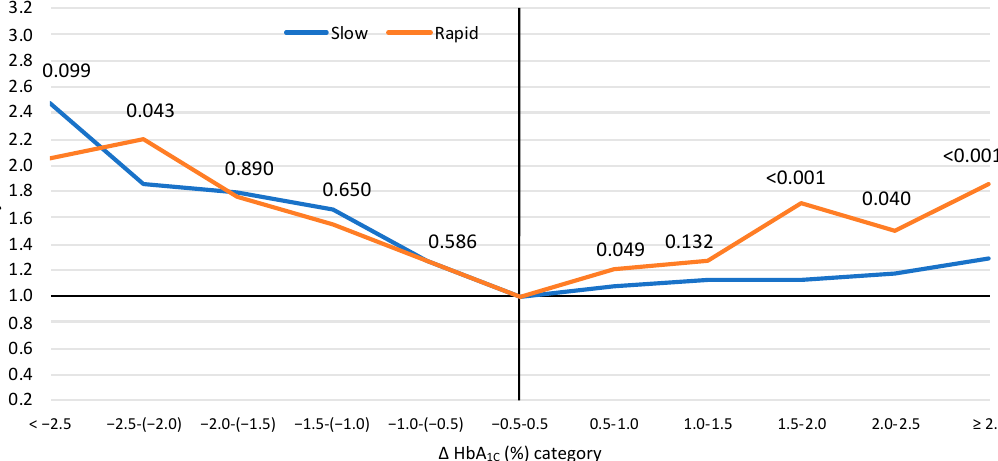
Figure 3. The relative risk (adjusted odds ratios) for mortality according to HbA 1C changes in the rapid- and slow-changing groups. Rapid change—time interval of ∆ HbA 1C values < one year; slow change—time interval of ∆ HbA 1C values ≥ one year. The numbers represent the p -values for disparity ( p for interaction) between the rapid- and slow-changing HbA 1C (separately for each ∆ HbA 1C category). Adjusted for: repeated measures, HbA1C levels, time from hospital discharge, age, sex, supraventricular arrhythmias, congestive heart failure, chronic ischemic heart disease, history of myocardial infarction, history of percutaneous coronary intervention, history of a coronary artery bypass graft, atrioventricular block, renal failure, diabetes mellitus, hypertension, peripheral vascular disease, chronic obstructive pulmonary disease, neurological disorders, malignancy, anemia, gastrointestinal bleeding, alcohol/drug addiction, type of acute myocardial infarction, severe left ventricular dysfunction, left ventricular hypertrophy and three-vessel/left-main coronary arteries disease. Abbreviations: AdjOR—adjusted odds ratio, HbA 1C —hemoglobin A 1C , HbA 1C change ( ∆ HbA 1C )—the difference between two HbA 1C tests (later–earlier).